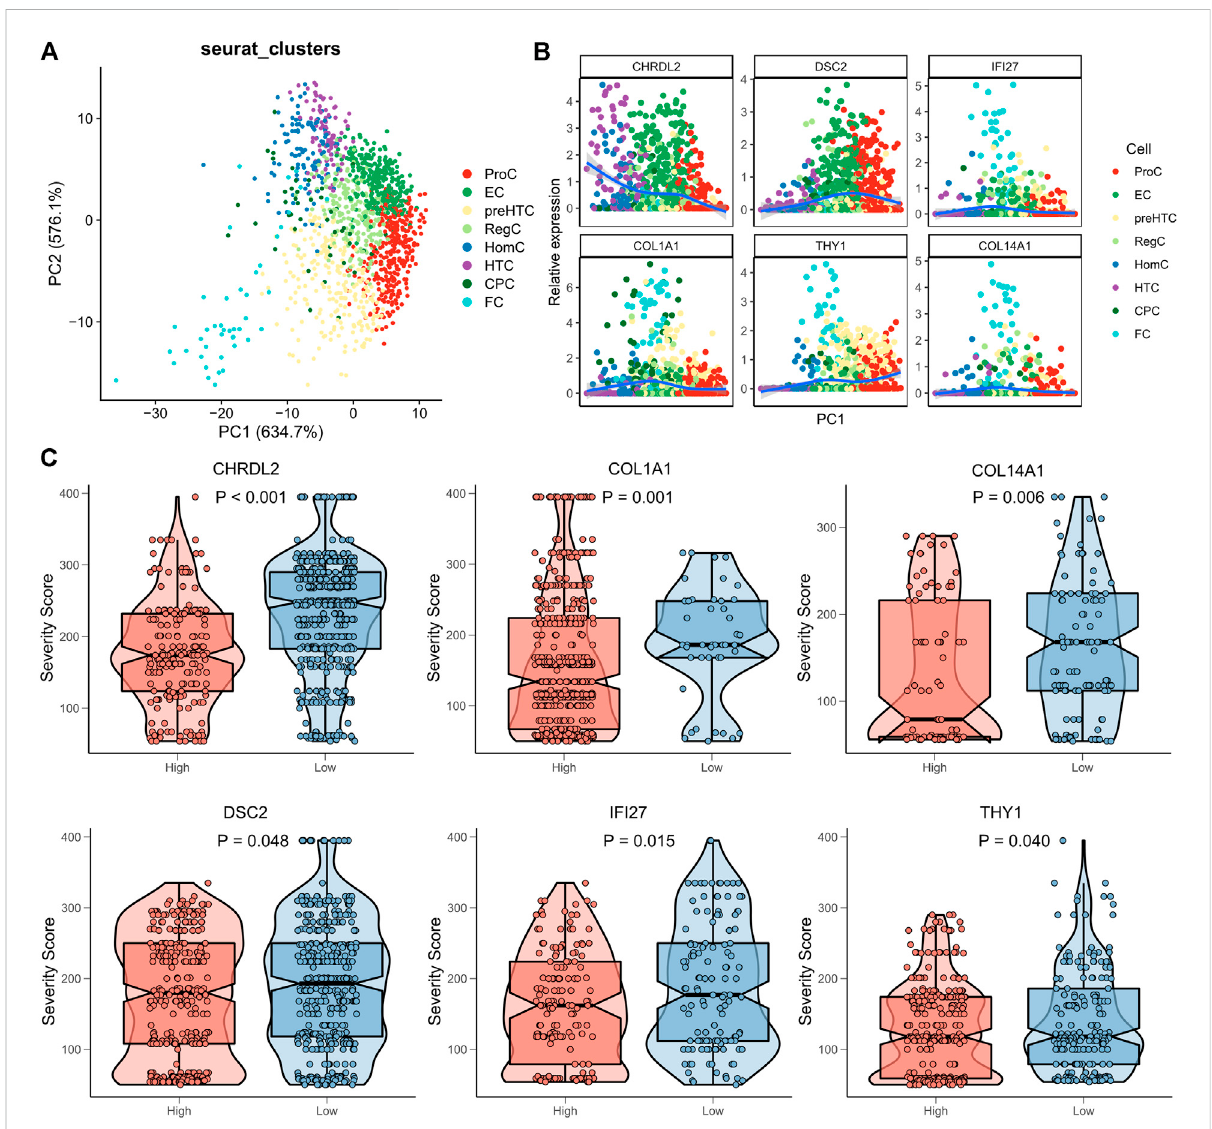
FIGURE 6 Clinical signi fi cance of marker genes of ECs and FCs. (A) PCA plots showing the distribution of the 8 cell clusters based on their marker genes; (B) ExpressionpatternofcanonicalmarkergenesalongPC1; (C) TheboxplotsshowingtheassociationbetweentheSeverityscoreandexpressionof gene markers (red for high expression and blue for low